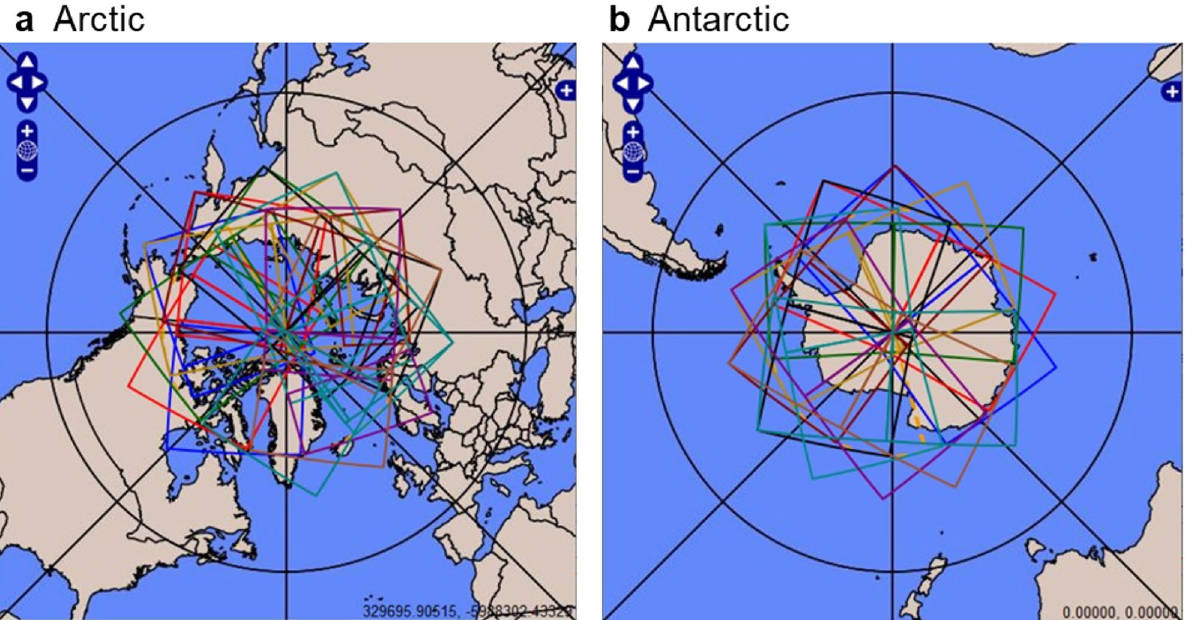
Figure 1. Area coverage for a typical 24-h period of the ( a ) Arctic and ( b ) Antarctic for the MetOp-A AVHRR. Overlap of swaths occur closer to the poles. (Image downloaded from the NOAA CLASS image search